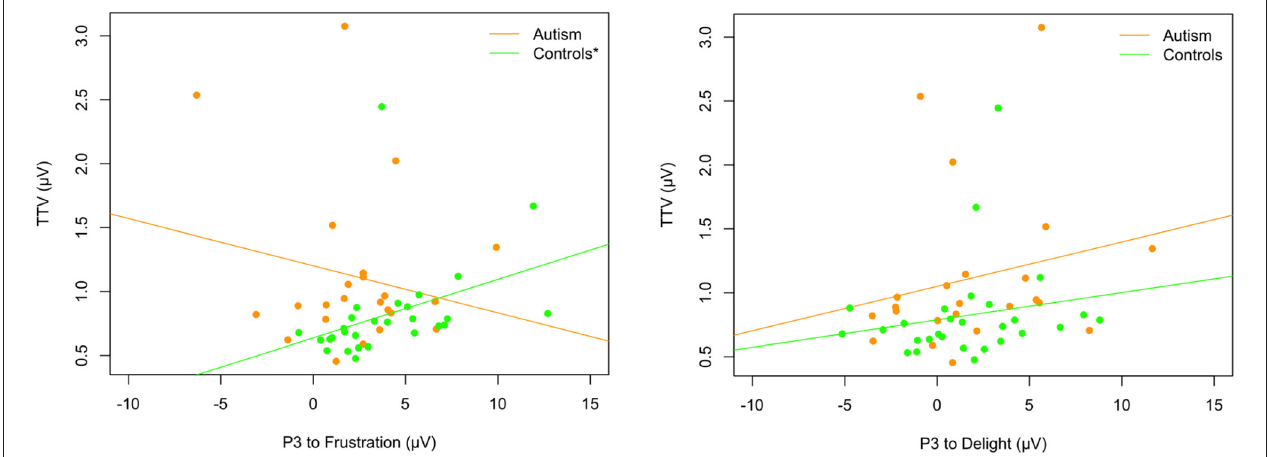
FIGURE 11 | Relationship between trial-to-trial variability and P3 to the change from delight to frustration (left) and from frustration to delight (right) in autism (orange) and neurotypical controls (green). Asterix in legend (left) shows significant correlation for TTV and P3 to frustration in controls only.